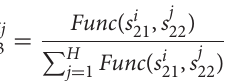
Spatial-attention